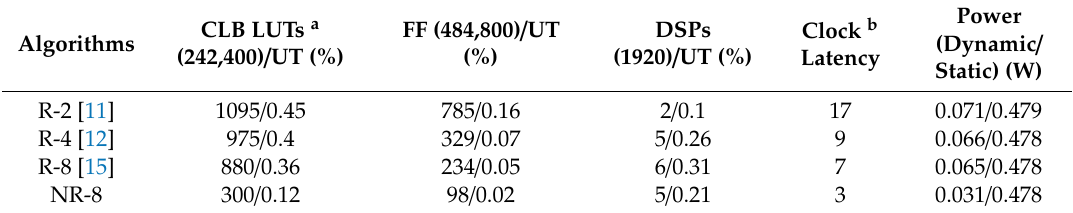
Table 2. Utilization comparison of the NR-8 CORDIC algorithm with the conventional CORDIC algorithms with 16-bit